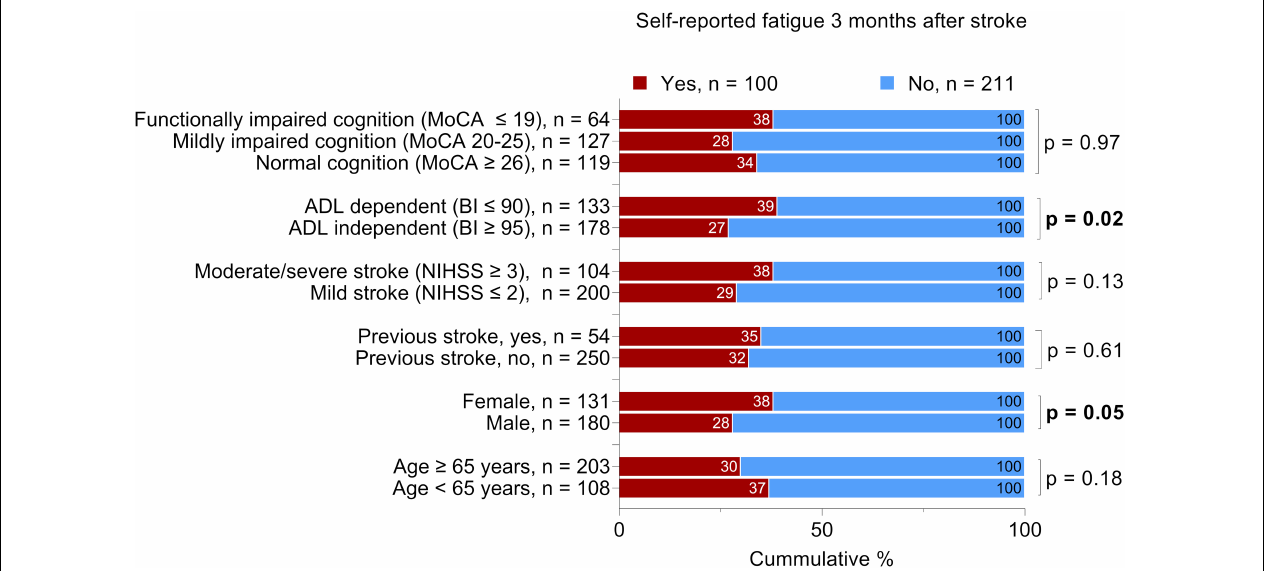
FIGURE 2 | Proportional distribution of the patients with self-reported feeling of fatigue 3 months after stroke. The total number of the patients per variable may vary due to missing data; Bold text indicates statistically significant results. Chi-squared was used for all analyses except for cognitive function, which was analyzed by the Mann-Whitney U test. MoCA, Montreal Cognitive Assessment; BI, Barthel Index; NIHSS, National Institutes of Health Stroke Scale. The MoCA and BI were administered 36-48 h after admission to the stroke unit. The NIHSS score was determined at admission.